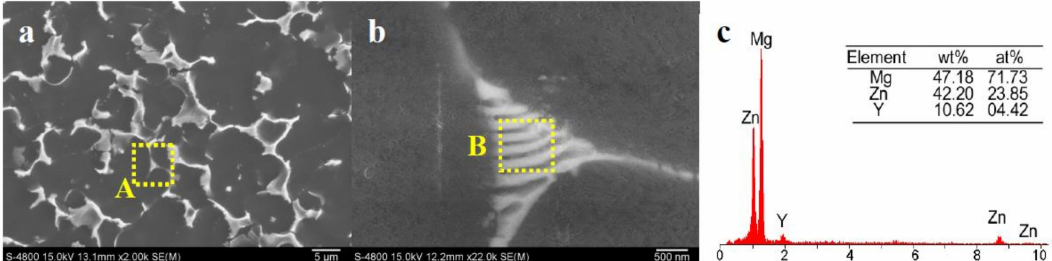
Figure 3. ( a ) SEM images of as-cast Alloy 3; ( b ) SEM morphology of lamellar eutectic marked by rectangle A in ( a ); ( c ) EDS analysis of lamellar eutectic marked by rectangle B in ( b